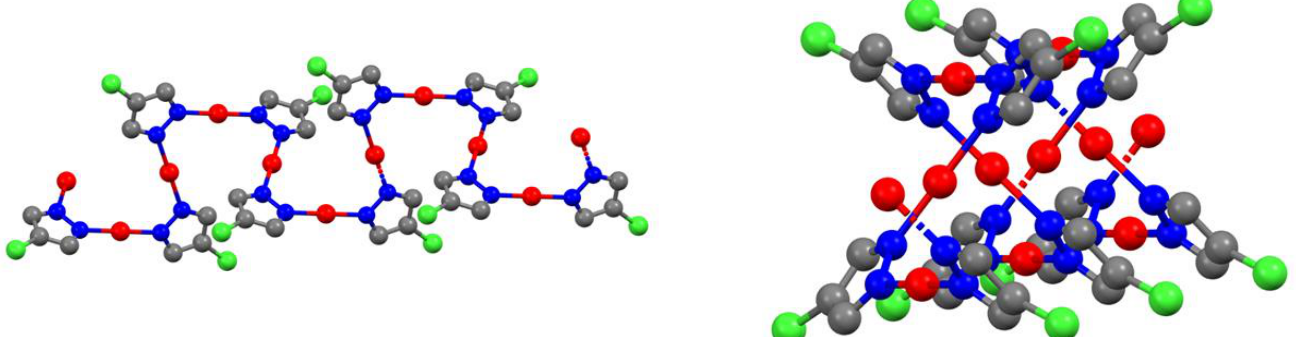
Figure 4. 1-D polynuclear structure of [Ag( µ -L1Clpz)] n ( left ) top view and ( right ) side view. Carbon atoms of isopropyl group and hydrogen atoms were omitted for clarity. Color: red, silver; blue, nitrogen; green, chlorine; grey, carbon.